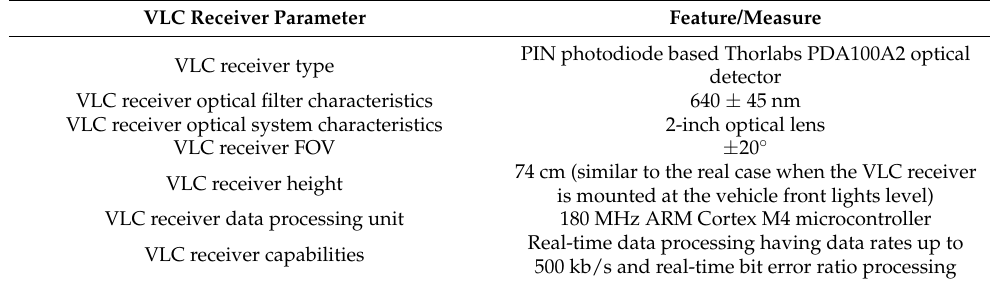
Table 3. Visible light communications receiver